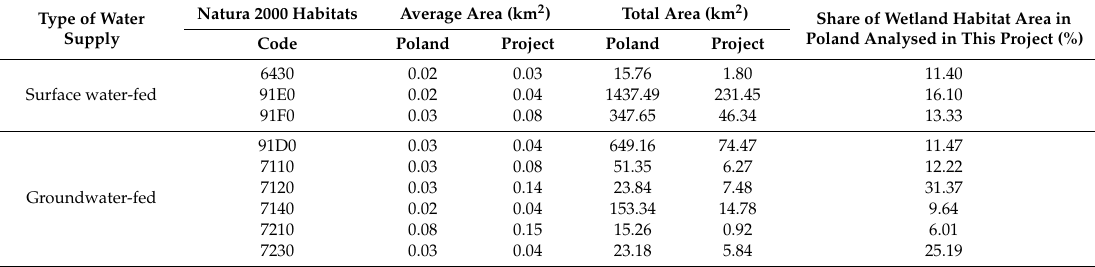
Table 2. Comparison of average and total Natura 2000 wetland habitat area (km 2 ) in Poland to area of habitats analyzed in this project. Percentage of total wetland habitat area in Poland analyzed in this